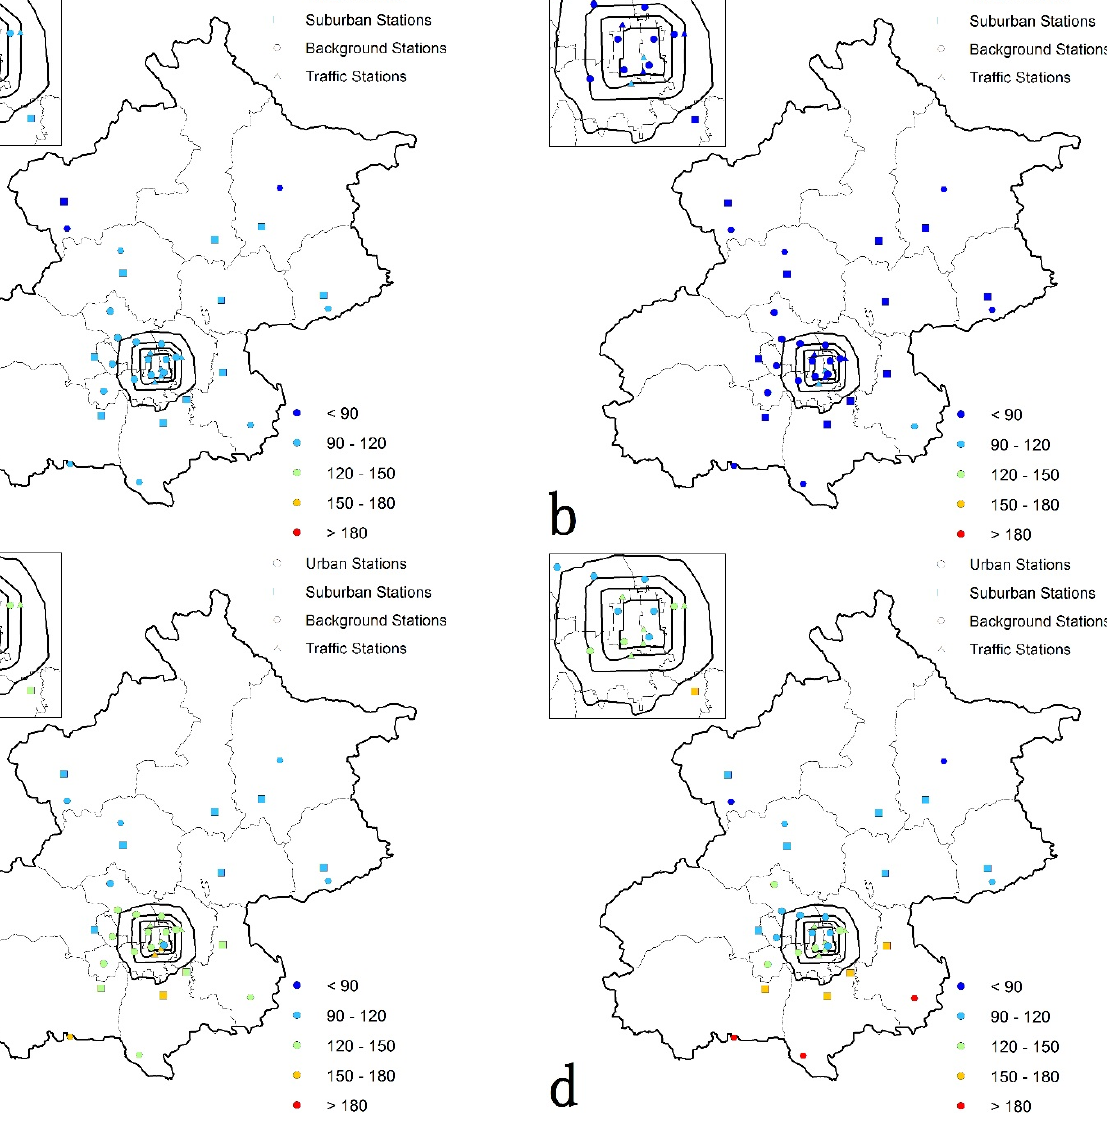
Figure 5. Seasonal variations of AQI for the 35 air quality monitoring stations (( a ) spring; ( b ) summer; ( c ) autumn; ( d )